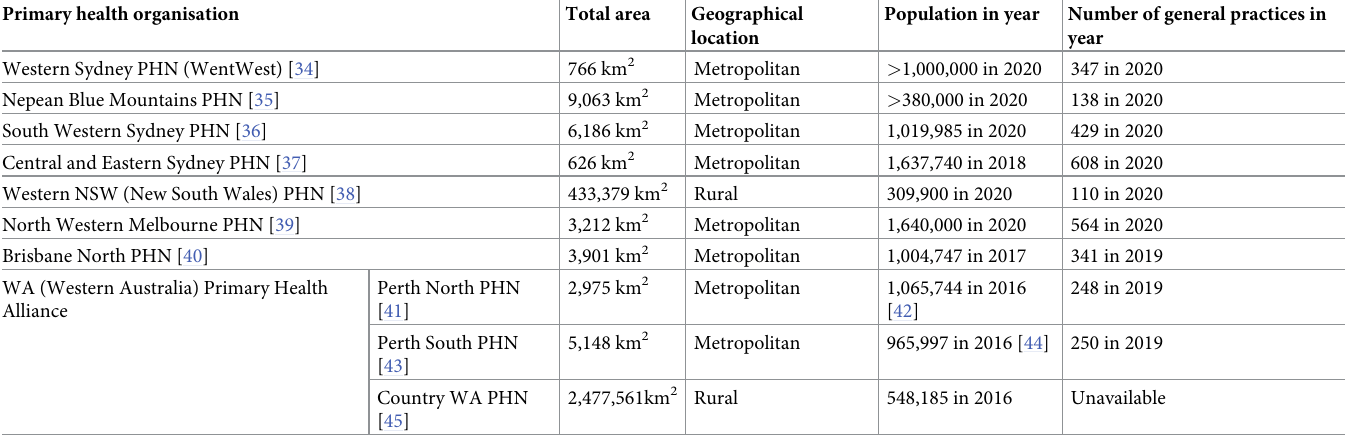
Table 1. Characteristics of the primary health organisations involved. Primary health